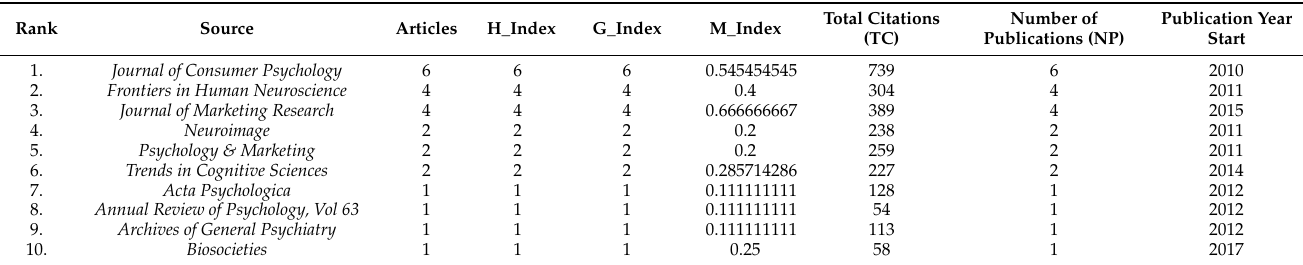
Table 6. Top 10 Most Relevant Sources and Source Local